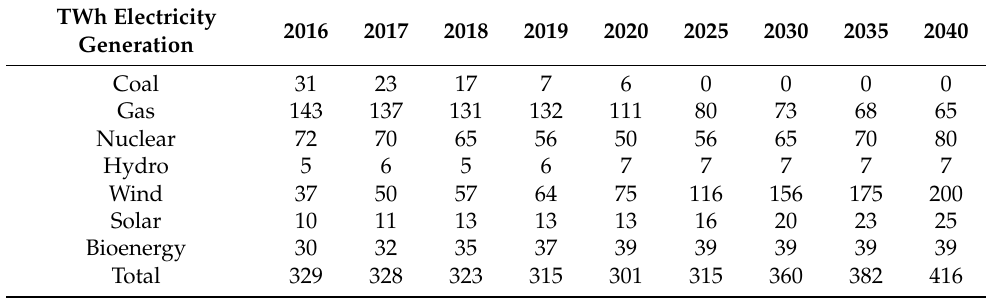
Table 3. The proportion of gas by the energy of the UK electricity generation forecasted for the years